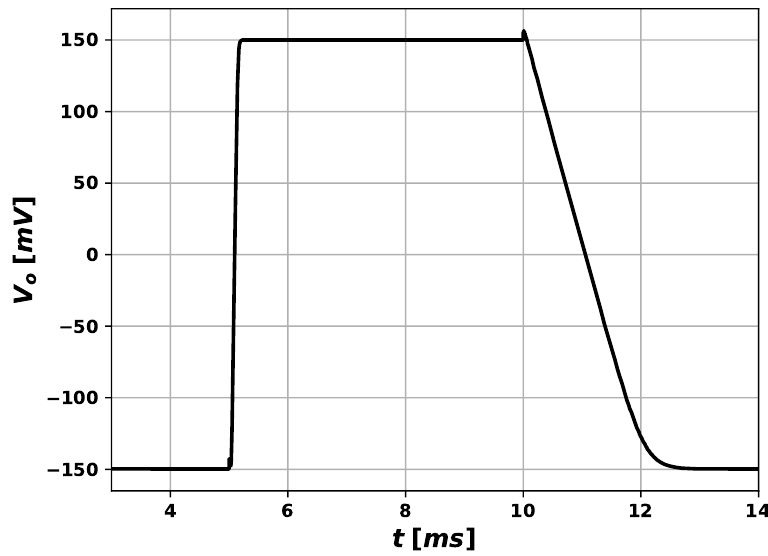
Figure 8. Response to a full swing input step.